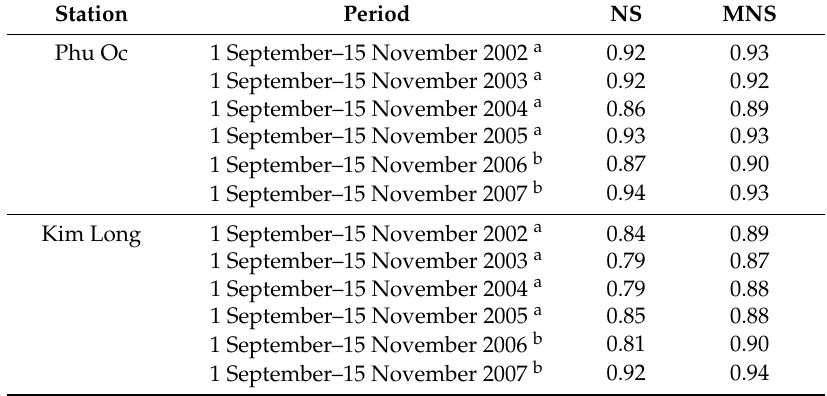
Figure 4. Comparison between simulated and observed flow for the 2007 flood season at the Binh Dien gauging station at the Huu Trach River. Table 2. Performance criteria of the hydraulic Hydrologic Engineering Center River Analysis System (HEC-RAS) flood prediction model for the two gauging stations in the Huong floodplain. NS: Nash-Sutcliffe efficiency for water levels; MNS: modified Nash-Sutcliffe efficiency for high water levels.